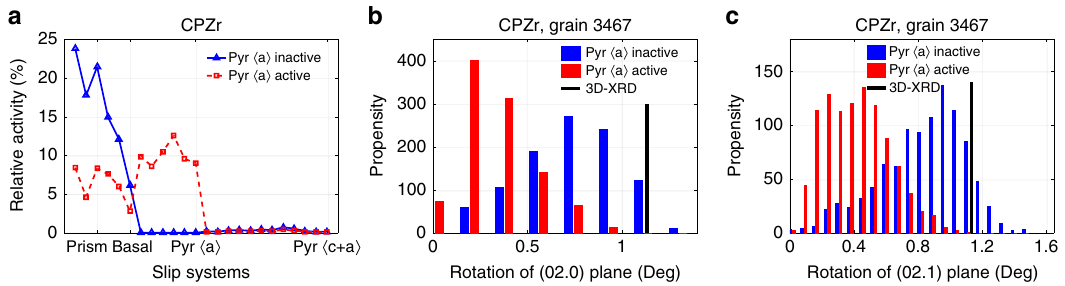
Fig. 4 Effects of 〈 a 〉 pyramidal slip activity. a Relative activity of all grains for the two examined CPFE models. Comparison between measured and calculated rotations of ( b ) (02.0) and ( c ) (02.1) planes for the two examined models